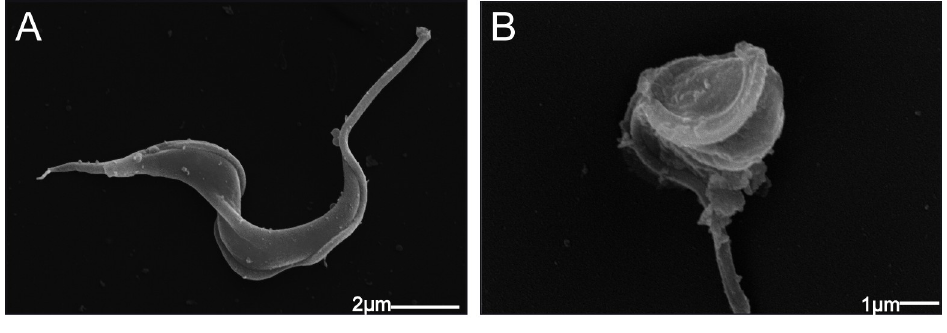
Fig 5. Scanning electron micrographs showing the morphology of trypomastigotes. A: Control untreated; B: Treatment with isoobtusilactone A (LC 50 ) for 2 hours.